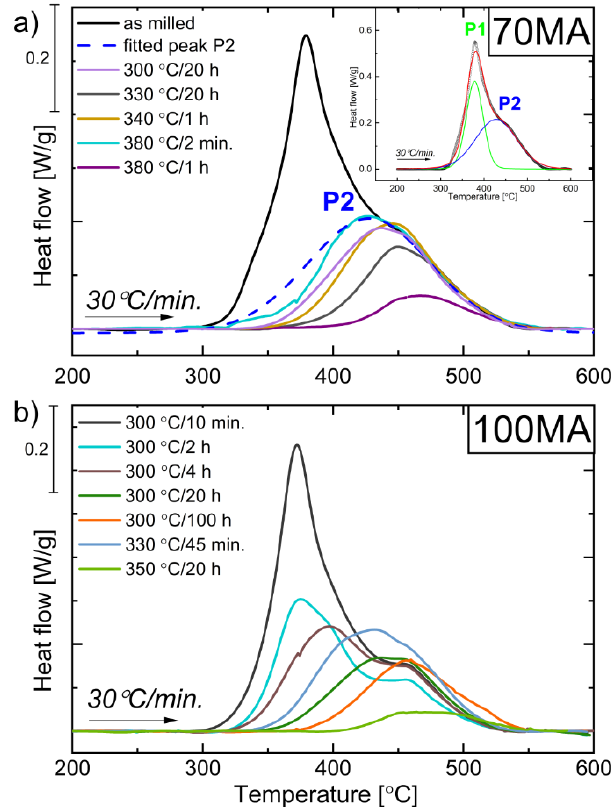
Figure 7. DSC curves recorded with the heating rate 30 °C/min for powders after: ( a ) 70 h of MA and annealed at 300 °C for 2 min, 330 °C for 20 h, 340 °C for 1 h, 380 °C for 2 min, and for 1 h; ( b ) 100 h of MA and annealed at 300 °C for 10 min, 2 h, 4 h, 20 h, 100 h, 330 °C for 45 min and 350 °C for 20 h. Inset—DSC line profile decomposition on P1 (green line) and P2 (blue line) processes.